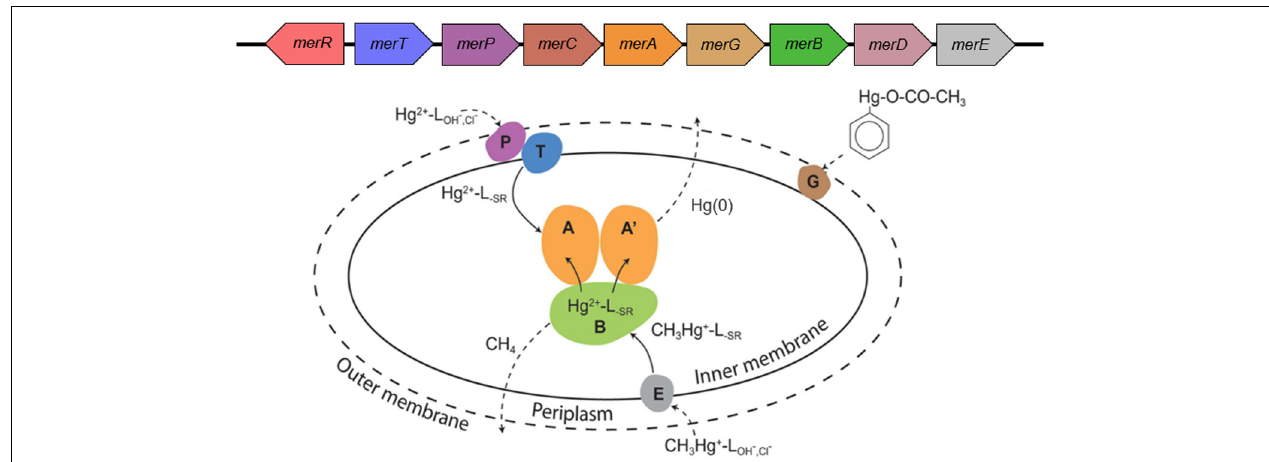
FIGURE 1 | The mer detoxification system. (A) A generic mer operon. (B) The cellular mer -encoded mercury detoxification mechanisms. The outer cell wall is depicted by a broken line illustrating that not all microbes have an outer membrane; broken line arrows depict diffusion; solid line arrows indicate transport or transformations; L = ligand with subscripts denoting the ligand type. The colors of various Mer proteins correspond with the colors of the genes that encode these proteins in panel A . Figure adapted from Lin et al. (2011); Boyd and Barkay